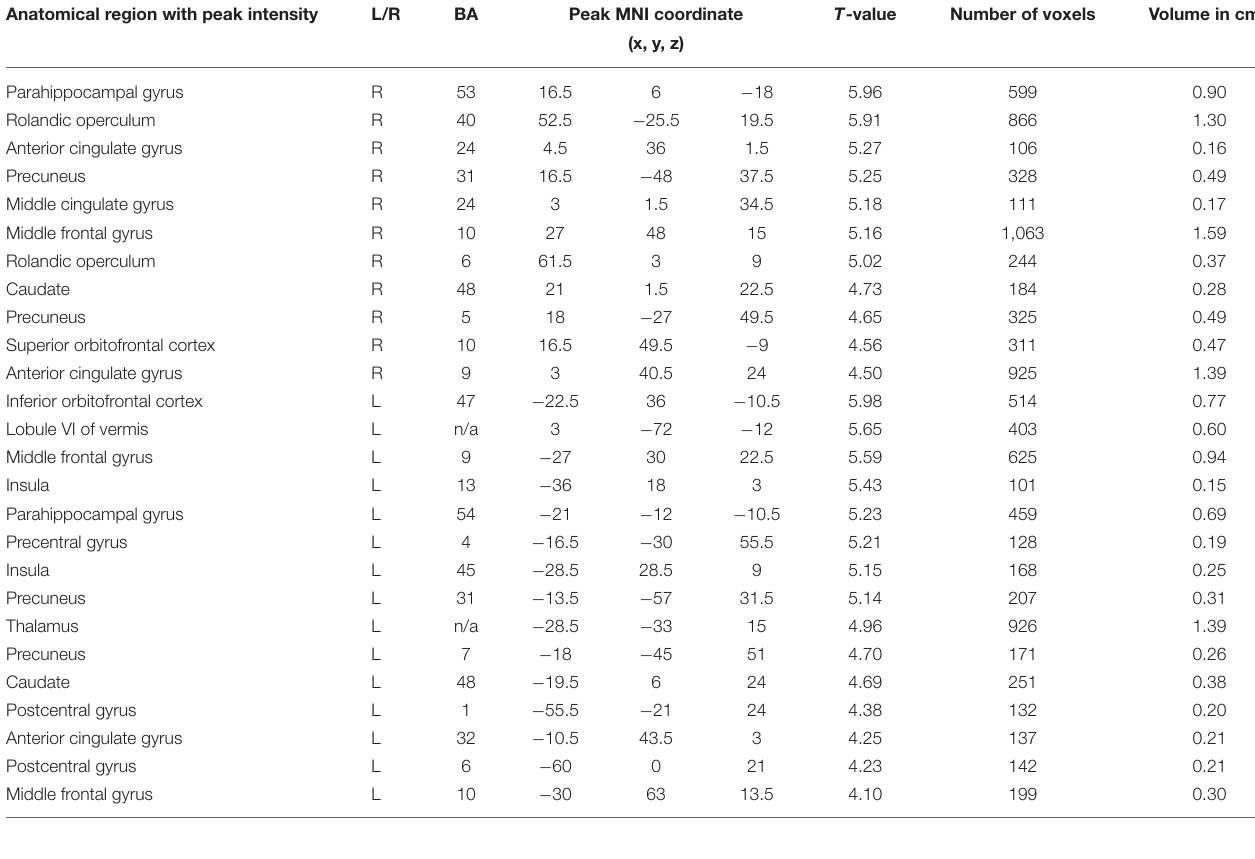
TABLE 2 | Brain areas showing a significant correlation of BOLD signal with delta band PSD (FDR corrected, p < 0.05, T < 3.47, cluster threshold > 100). Anatomical region with peak intensity L/R